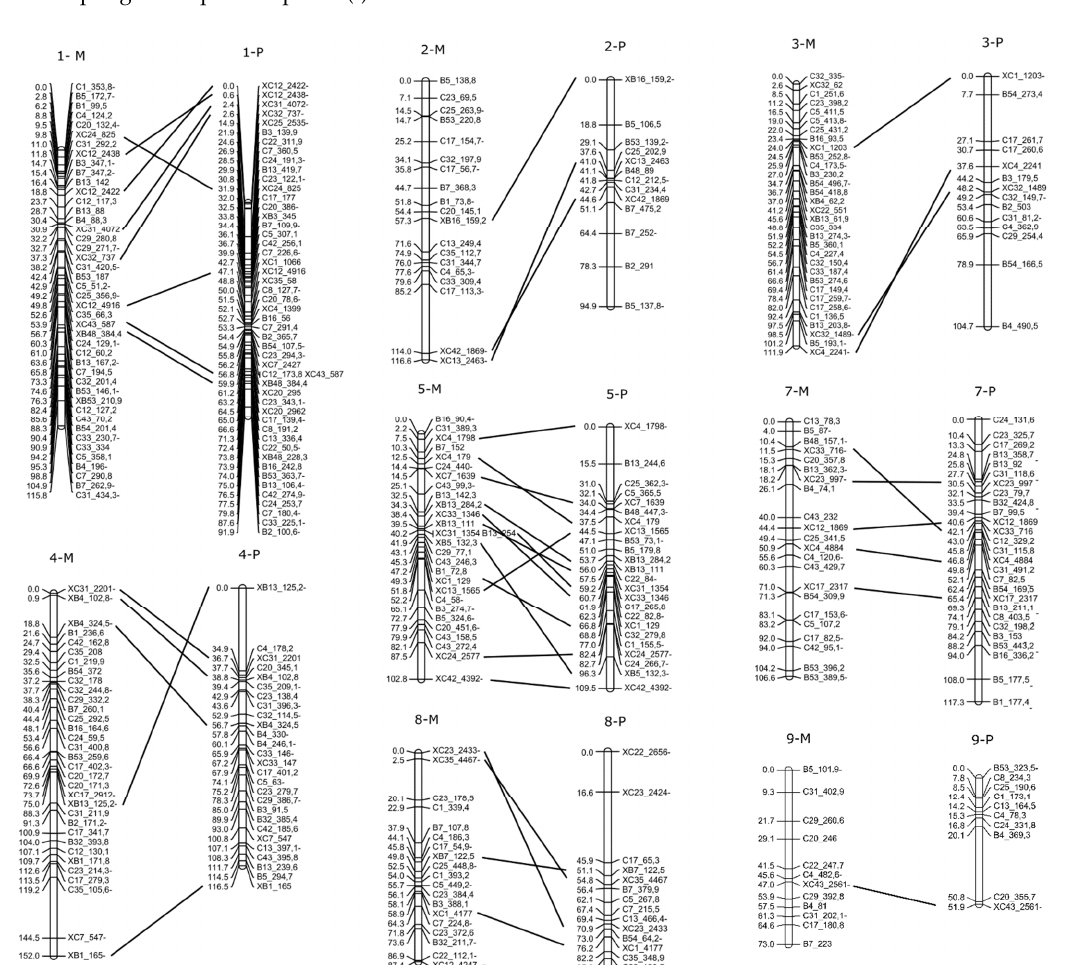
Figure 7. Maternal (M) and paternal (P) homologous chromosomes identified by BSDF (starting with an X). Marker’s names and distances in cM (Kosambi) are indicated on the right and the left, respectively. The relative order of BSDF markers between both maps is indicated by horizontal lines. A linear regression analysis was performed combining phenotypic information of F 1 hybrids, as the dependent variable, and genotypic data derived from the mapping pro- cedure, as the independent variable [70,71]. Due to the variation of the %AES between locations, F 1-C and F 1-Z populations were analyzed separately. This single-marker analysis detected a total of 40 significant associated markers ( p < 0.05) with an R 2 from 0.1 to 0.34. The evaluation of the F 1-C showed 26 markers associated with apospory expressivity (0.1 < R 2 < 0.34), 23 of which were included in the map. As three of them had been previously eliminated by similarity, their position specifications correspond to those similar mapped markers (B16_164.6, C29_332.2, C32_244.8), the other three remaining unlinked (Table 6). As shown in Table 6, the LGs with the highest number of associated markers were: LG3, with a total of seven markers, six maternal (M), and one paternal (P), and LG4 with a total